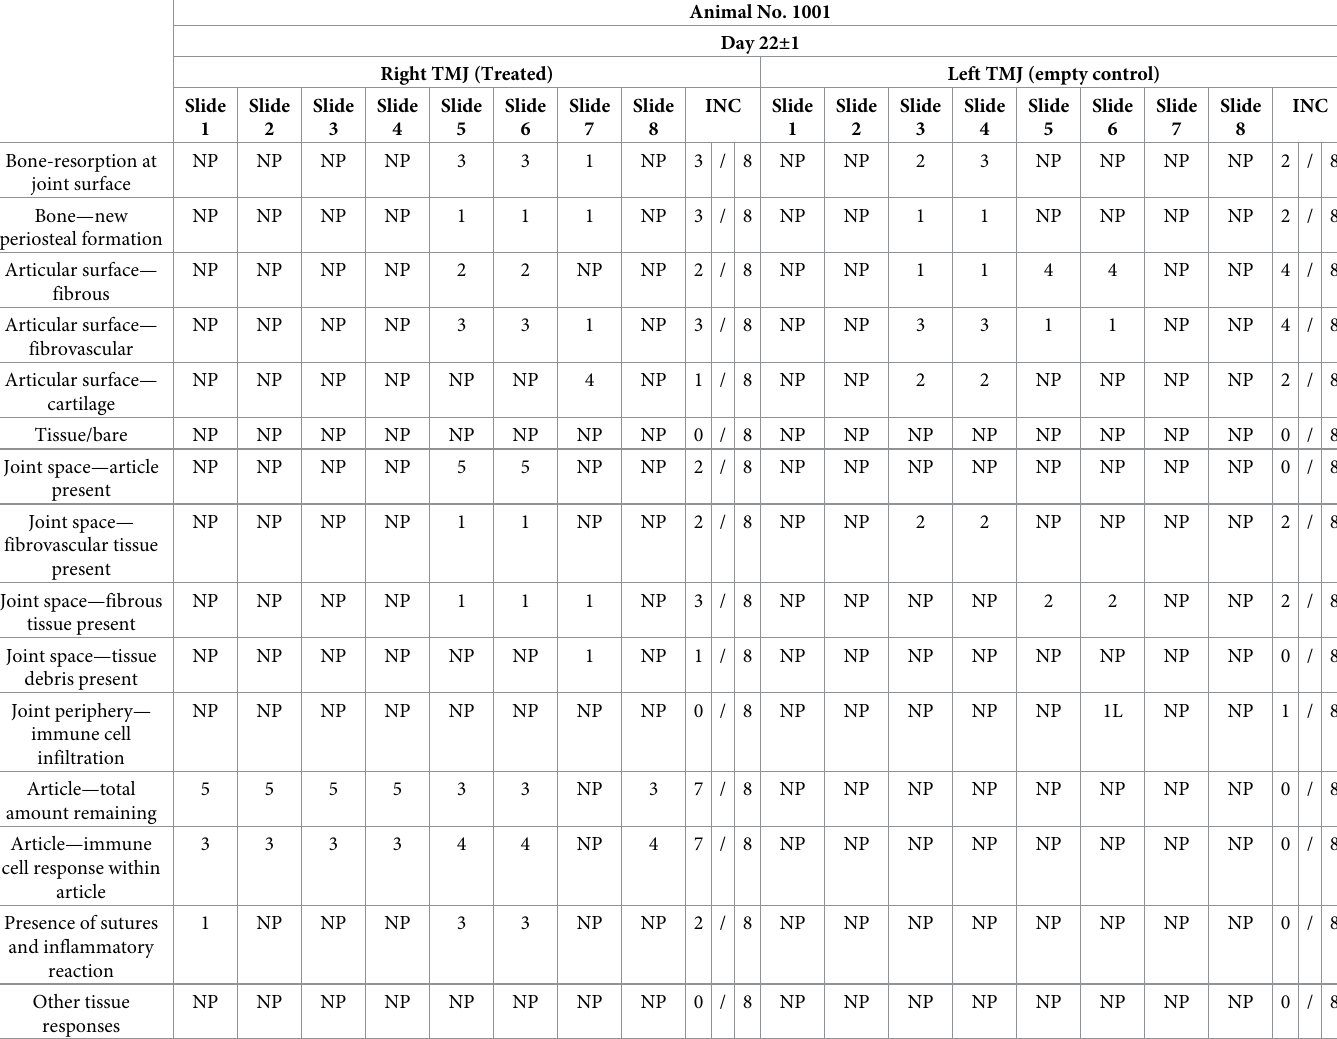
Table 8. Individual histopathological findings for animal